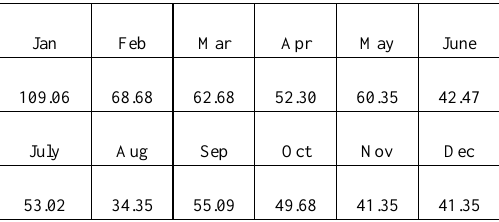
Table 3. Beijing PM2.5 average concentration (ug/m 3 )